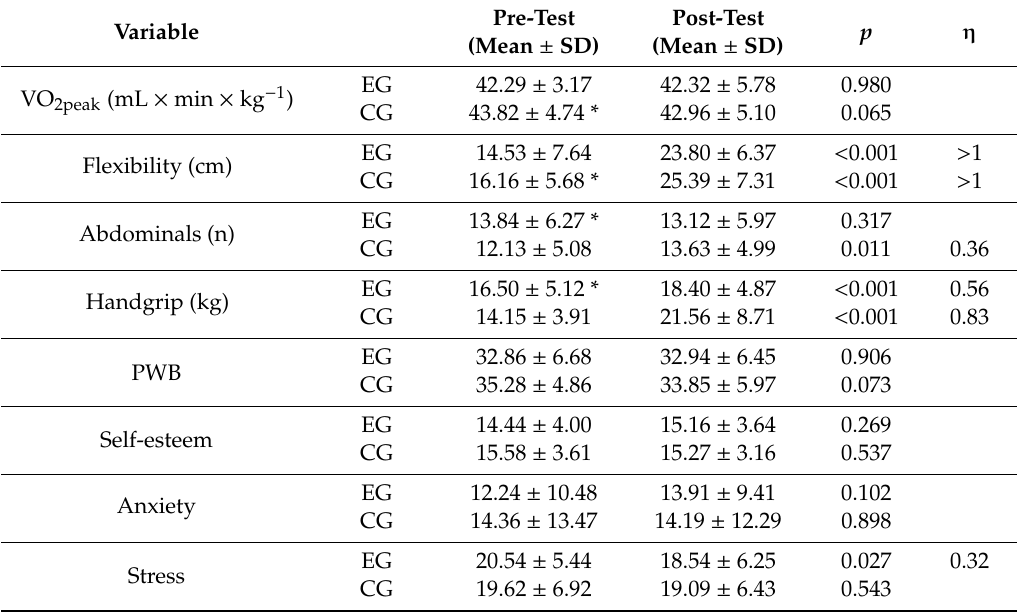
Table 2. Results of the paired pre- and post-test comparison for the experimental and control group. Variable